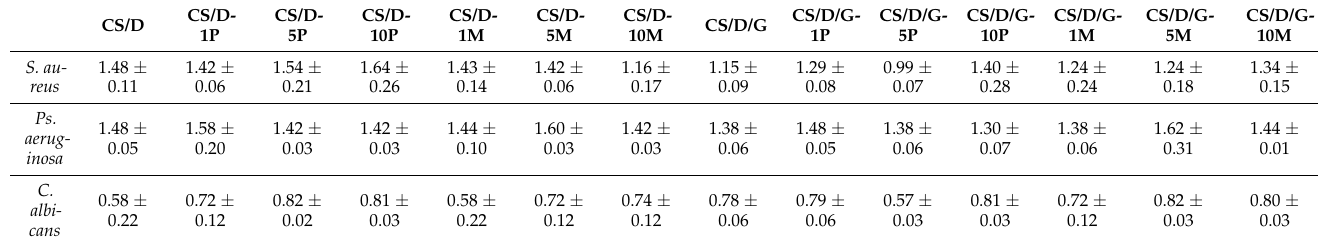
Figure 11. Antimicrobial activity expressed as logarithmic reduction (lg) for hydrogel samples on three reference microorganisms; * p value < 0.03 ( n = 3). Table 3. Antimicrobial activity of hydrogel samples expressed as logarithmic reduction values.